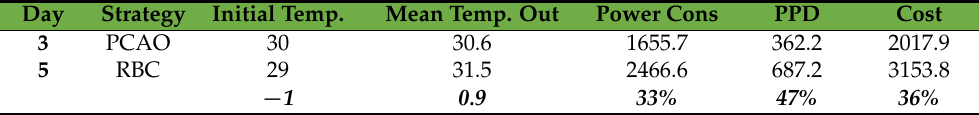
Table 5. Comparison between the PCAO (third) and RBC (fifth) summer days.